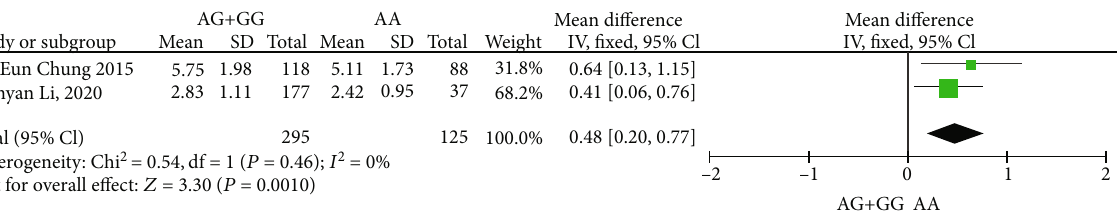
Figure 3: Forest plots showing the in fl uence of NQO1 rs10517 on warfarin maintenance dosage. Relative warfarin dosage requirement of NQO1 rs10517 G carriers (GA or GG carriers) compared to AA carriers (wild-type). Mean (SD): mean and standard deviation of normalized warfarin doses associated with each genotype. WMD: weighted mean di ff erences; CI: con fi dence interval.